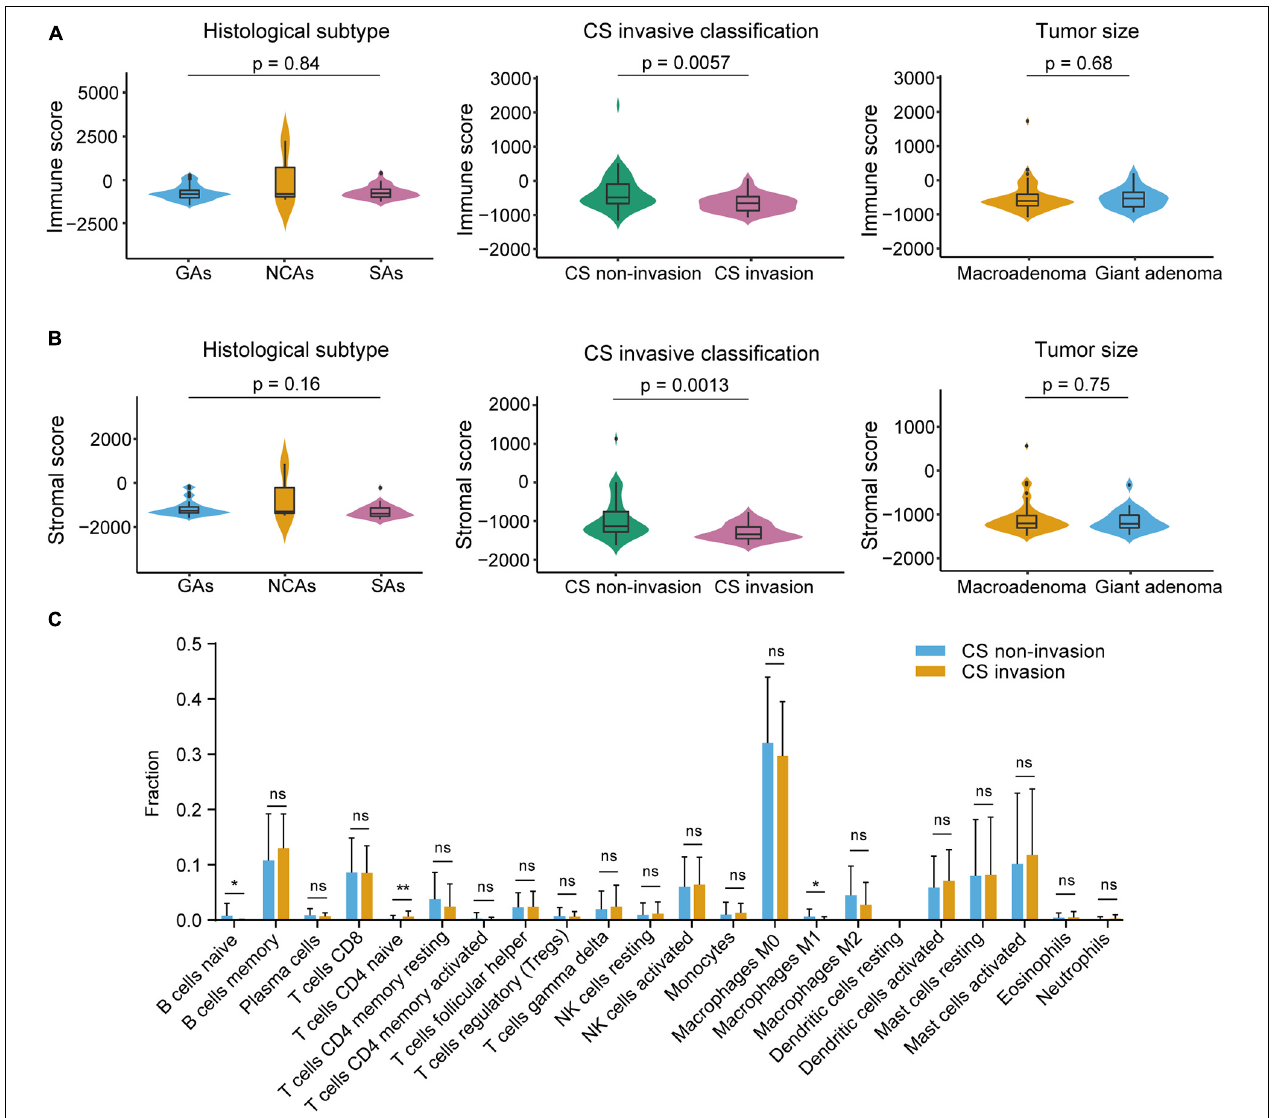
FIGURE 1 | Immune and stromal scores were not correlated with histological subtype, tumor size, but were correlated with cavernous sinus (CS) invasion. (A) Distribution of immune scores plotted against histological subtype ( p = 0.84), CS invasive classification ( p = 0.0057), tumor size ( p = 0.68). (B) Distribution of stromal scores plotted against histological subtype ( p = 0.16), CS invasive classification ( p = 0.0013), and tumor size ( p = 0.75). (C) CIBERSORT analysis of the proportions of 22 tumor infiltrating immune cell types between CS invasion and CS-non-invasion group (1000 permutations). * p < 0.05; ** p < 0.01; ns, not